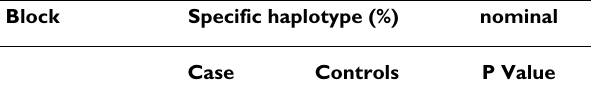
Recessive Dominant O.R.+C.I . P value [22]<->[11]